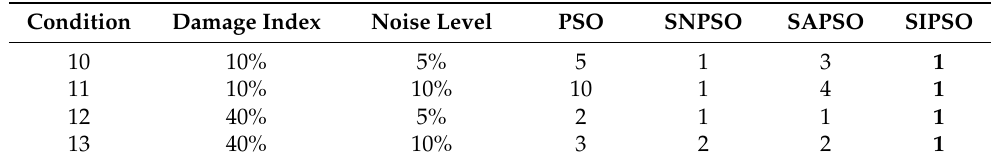
Figure 9. Triple damages detection results of four PSO-based algorithms: ( a ) 10% damage index with 5% noise level; ( b ) 10% damage index with 10% noise level; ( c ) 40% damage index with 5% noise level; ( d ) 40% damage index with 10% noise level. Table 7. Numbers of misjudgments in damage detection of four PSO-based algorithms with triple